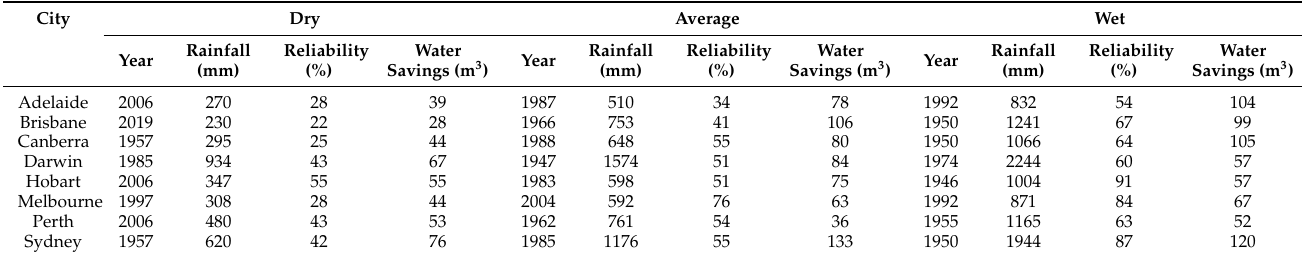
Figure 11. Average monthly rainfall for the selected eight cities. Table 2. Summary of dry, average and wet year rainfall, reliability and water savings for different cities (10 m 3 combined use).